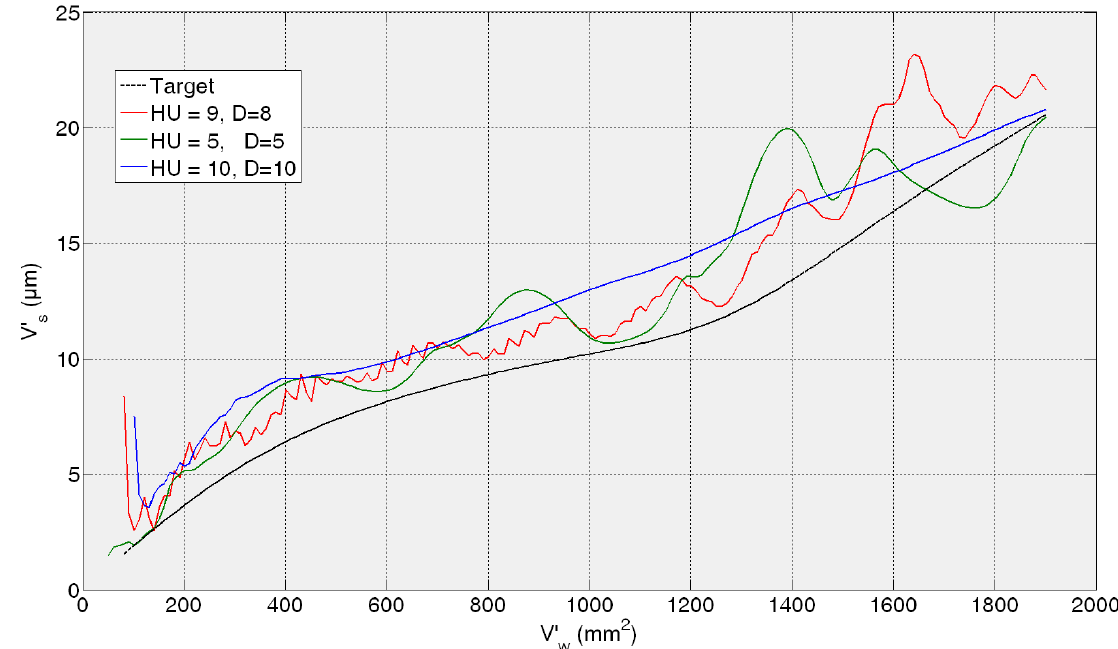
Figure 8. Generalization capability of the three preselected configurations . Test experiment : 82AA70G6VW q = 60; Q' = s